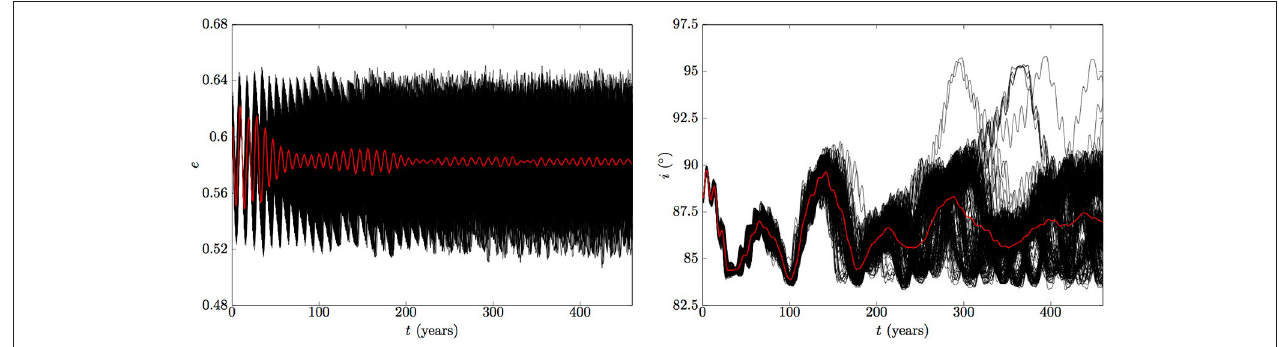
FIGURE 7 | Ensemble integration of a cluster of k 200 orbits in a neighborhood V ( x ⋆ ) of x ⋆ (0.616,88 ◦ ). The ensemble averaged orbit of the considered = = observables are shown in red . The eccentricities do not experience a net sensitive dependence to the ICs, contrarily to the inclinations. From this example, it can be